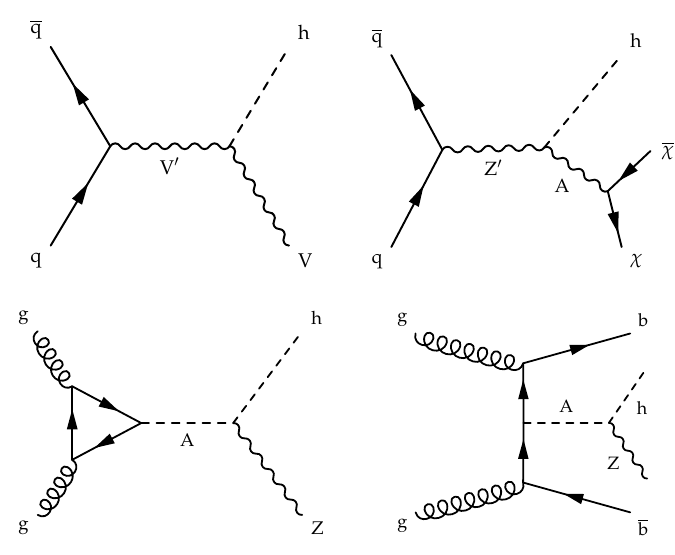
Figure 1 . The leading order Feynman diagrams of the processes considered: heavy spin-1 vector boson production (V 0 ) and decay to an SM vector boson (V) and a Higgs boson (h) in the HVT framework (upper left); Z 0 boson that decays to a Higgs boson and an A boson, with the latter decaying into dark matter particles ( (cid:31)(cid:31) ), predicted by the Z 0 -2HDM model (upper right); produc- tion within the 2HDM model of a pseudoscalar A boson through gluon-gluon fusion (lower left) and with accompanying b quarks (lower